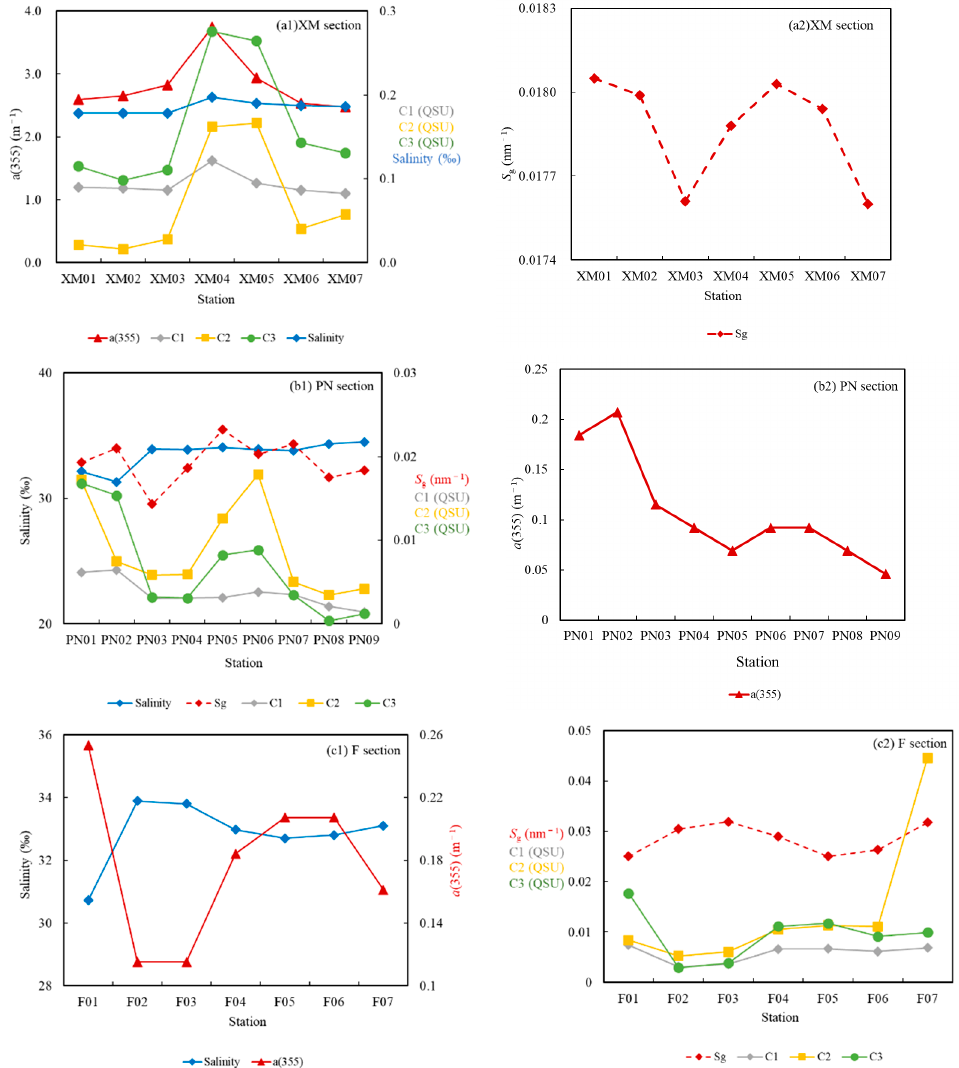
Figure 13. a ( 355 ) (m − 1 ), S g (nm − 1 ), salinity (‰), and the fluorescence intensity of the fluorophores (QSU) along the three sections. ( a1 , a2 ) section XM; ( b1 , b2 ) section PN; and ( c1 , c2 ) section F. Usually, C3 is associated with biological production [83], but the covariation in C3 and C2 along section XM mostly suggests that C3 contains tryptophan-like peak T (de- rived from an allochthonous source), which was noted by Hong et al. [84] in the Jiulong River watershed, and has been verified by its correlation with the tryptophan-like com- ponent. Along section PN (Figure 13(b1,b2)), the (355) a and C1 vary consistently with the DOC, suggesting the predominance of the terrestrial materials carried by the CDW and that the diffusion of the CDW is the basic hydrodynamic process. However, C2 and C3 vary differently than C1. They decrease gradually (similar to C1) at the first four stations, but they increase unexpectedly at stations PN05 and PN06. This is accompanied by ab- normal increases in the Chl-a concentration from 0.75 μ g L − 1 at station PN04 to 1.29 μ g L − 1 at station PN05 and to 1.09 μ g L − 1 at station PN06. Because they are protein-like fluores- cence components, C2 and C3 are usually attributed to autochthonous production during the exponential growth of phytoplankton [67]. Usually, high chlorophyll-a concentra- tions are observed in the Changjiang Estuary, especially in spring when the TWC con- verges with the saline water on the continental shelf [85], which promotes the aggrega- tion of marine autochthonous substances. Thereafter, in addition to the terrestrial mate- rials carried by the CDW, autochthonous DOM is also a main source of the DOC along section PN. The regional occurrence of marine autochthonous substances could be one of the main factors impairing the conservative behavior of the DOC along section PN. Along section F (Figure 13(c1,c2)), C1 continuously decreases from station F01 to station F03, and it abruptly increases at station F04. Station F04 is located in the south- western part of a cyclonic eddy to the southwest of Jeju Island, where materials from both the Changjiang Basin and the Old Huanghe Delta settle to the bottom [86]. This unex- pected sustained increase in C1 at certain stations may suggest the input of additional terrestrial materials at station F04, except for the materials from the Changjiang Basin carried by the CDW.